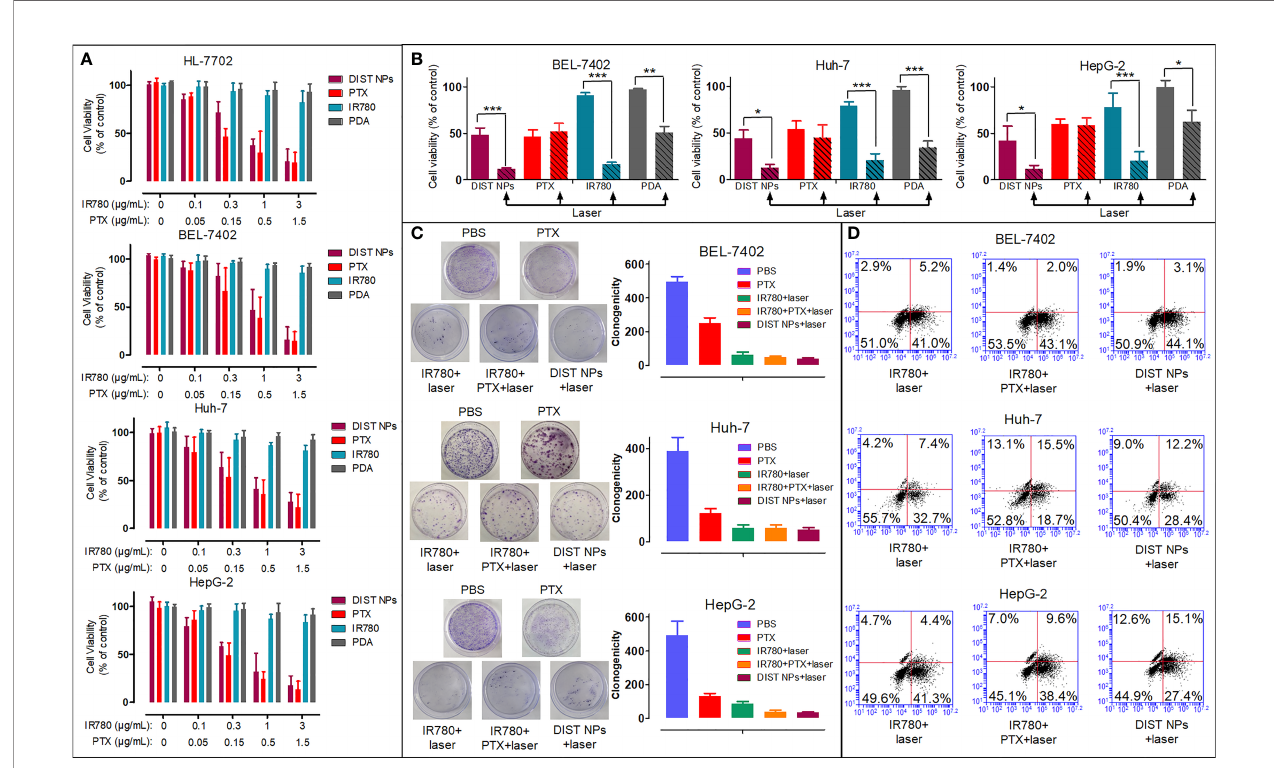
FIGURE 4 | The in vitro cell inhibition results of the DIST NPs in Huh-7, BEL-7402, HepG2, and HL-7702 cells (n = 3) (A) . The in vitro PTT effect of the DIST NPs and their main components (n = 3) (B) . The colony formation test results of the DIST NPs and their main components (n = 3) (C) . The fl ow cytometry results (D) . The * represents p < 0.05; **p < 0.01; and ***p <